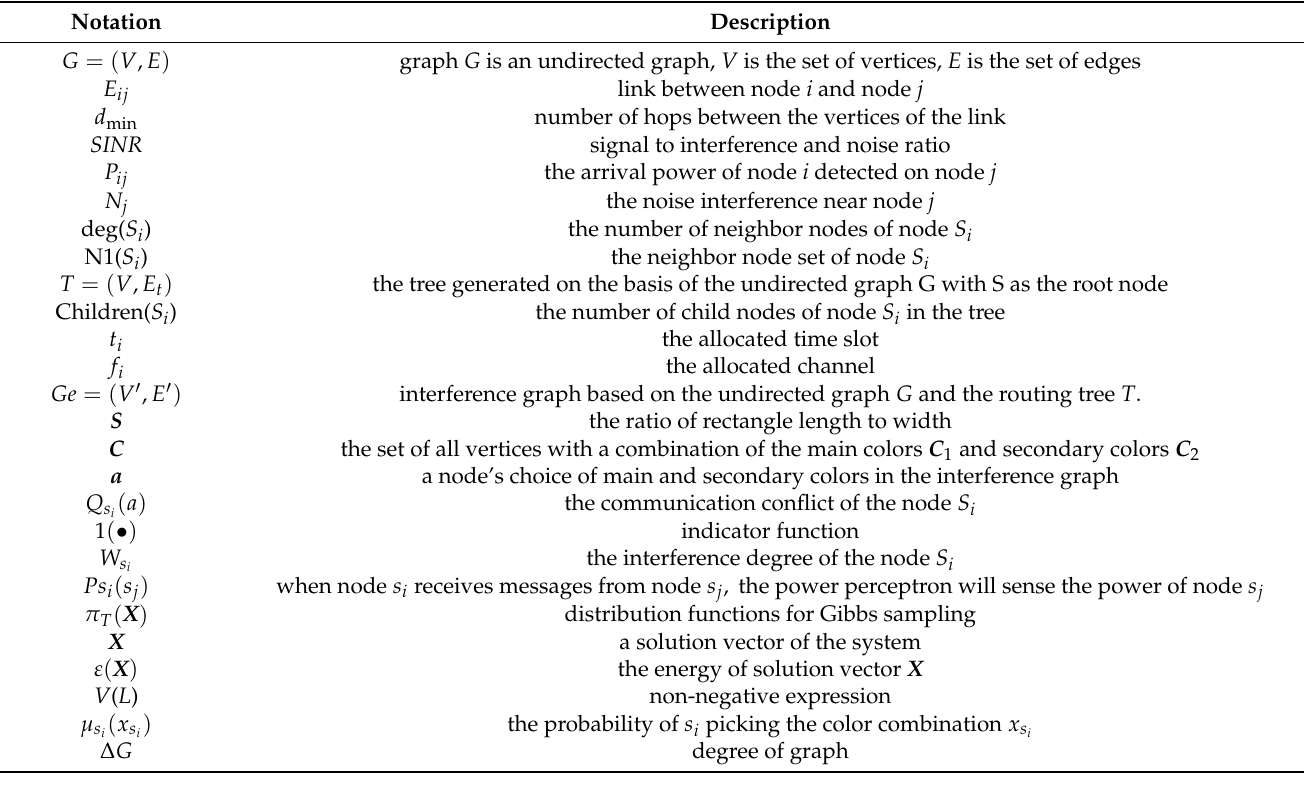
Table 1. Description of notations.